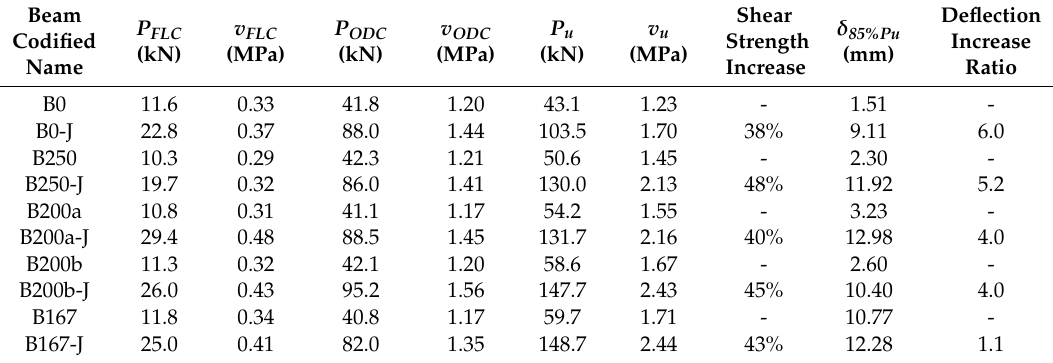
Figure 9. Comparison of the experimental behavior of the examined beams (initially tested and jacketed beams) in terms of average shear stress versus mid-span deflection. Table 3. Test results of the examined beams (initially tested and jacketed beams).